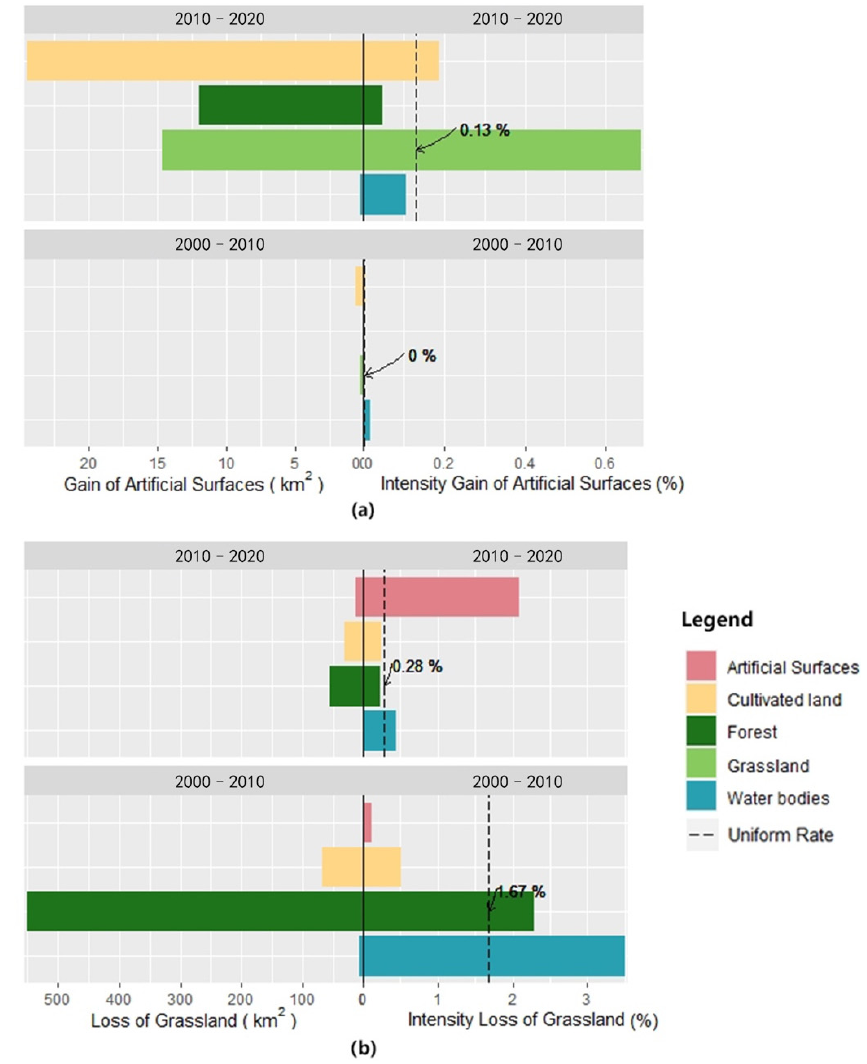
Figure 7. Intensity of change at the transition level. Each bar plot combines the area of change (bars that extend to the left of zero) and intensity of change (bars that extend to the right of zero). ( a ) Transition intensity analysis to artificial surfaces for two time intervals: 2000–2010 and 2010–2020. ( b ) Transition intensity analysis from grassland for two time intervals: 2000–2010 and 2010–2020. If a category’s bar extends beyond the uniform line (the dash line), then the gain or loss of the selected category targets this category. If a category’s bar ends before the uniform line, then the gain or loss of the selected category avoids this category.